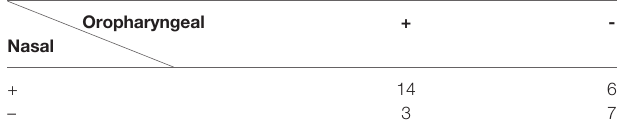
TABLE 1 | Detection of SARS-CoV-2 infection using nasal and oropharyngeal swabs in patients with con fi rmed COVID-19.